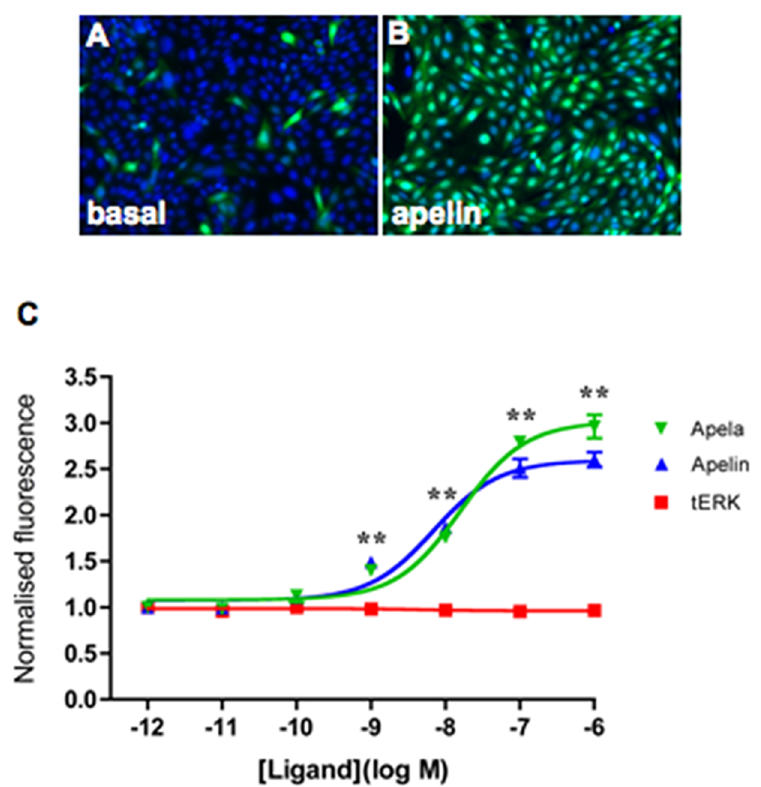
Fig 2. [Pyr 1 ]apelin-13 and apela-32 activatesERK1/2 in CHO-B78 cells. Cells were treated for 10min at 37˚C with the indicatedconcentration of ligands.Representative thumbnailimages acquiredby the IN Cell Analyzer1000 show immunohistochemicalstaining for intracellularppERK1/2 (green)after treatment of CHO-B78 cells with vehicle( A ) or 100nM[Pyr 1 ]apelin-13( B ). The workstation can automatically demarcate nucleusfrom cytoplasm accordingto DAPI (blue) nuclearstaining. A dose-response curve (whole-cell immunofluorescenceexpressed in arbitrary units) for [Pyr 1 ]apelin-13 (blue) or apela-32(green)is shown in ( C ). There are no measurable dose-dependentchangesin tERK levels (red) in cells stimulated with apela-32 —a similar result was obtainedwith cells stimulatedwith [Pyr 1 ]apelin-13.The [Pyr 1 ]apelin-13and apela-32 stimulationswere performed in separate cell wells (cells were used from the identicalCHO-B78 passage number) and processedfor ERK immunohistochemistry in the same experiment. Data are expressedas mean ± SEM, averagedfrom two separateexperiments, each ligandconcentration or vehicle (basal) with triplicate wells, and at least triplicate fields within wells. ** p < 0.01comparing stimulationsto basal conditions.